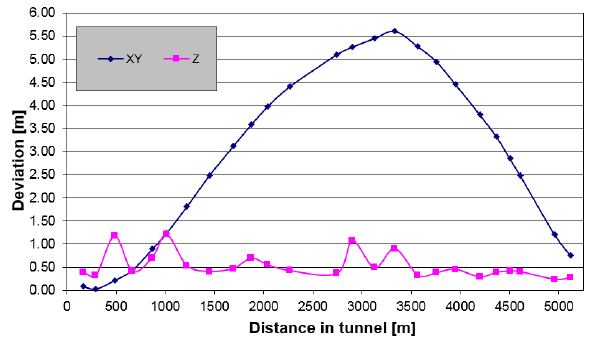
Figure 4: Deviation on GCPs without any adjustment